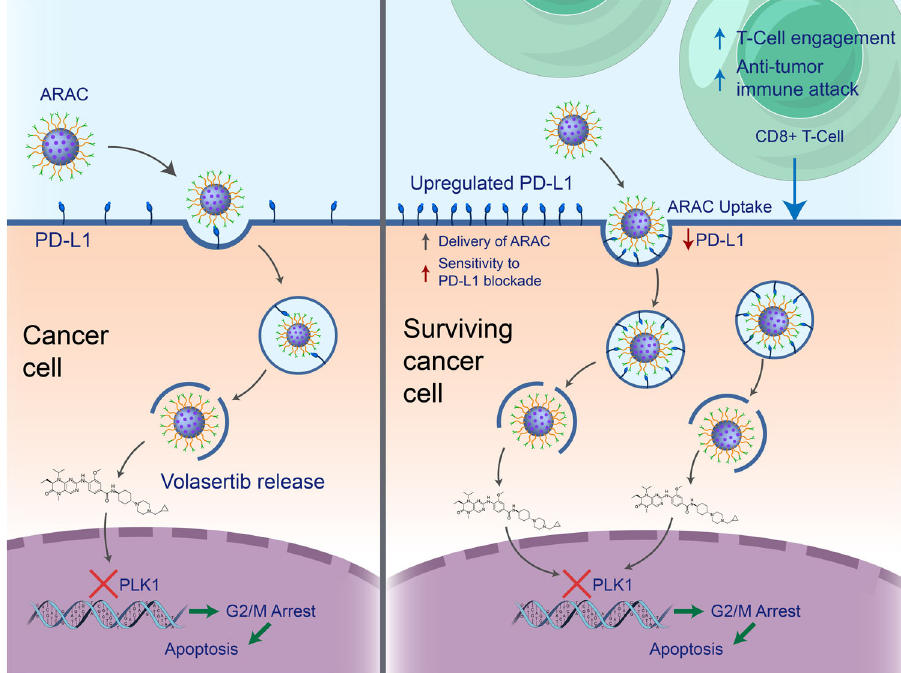
Fig. 8 Proposed mechanism of action of ARAC nanoconstruct. (Left cell) ARAC binds to PD-L1 on cancer cell surface and is internalized via receptor- mediated endocytosis. Endosomal escape of ARAC is mediated by PEI polymer 16 and volasertib is released to inhibit PLK1 activity, leading to G2/M cell cycle arrest and apoptotic cell death. However, G2/M arrest induced by volasertib upregulates PD-L1 levels in surviving cancer cells, thereby rendering them unresponsive to immune-mediated effects (due to PD-L1-mediated immunosuppression). (Right cell) We capitalize on this property by utilizing elevated PD-L1 levels in surviving cancer cells as the homing target for subsequent ARAC delivery, leading to cancer targeting in a feedforward manner (i.e., higher targeting with increased doses of the treatment). Enhanced delivery of ARAC results in loss of PD-L1, which allows for cytotoxic CD8 + T cells to effectively kill cancer and generate an anti-tumor immune